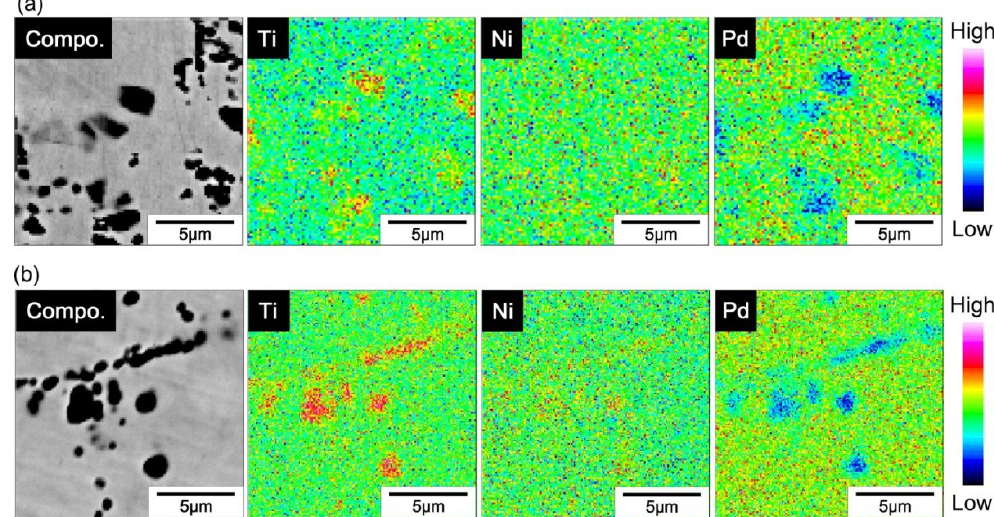
Figure 8. EPMA mapping of elements for ( a ) 49Ti alloy and ( b ) 52Ti alloy.